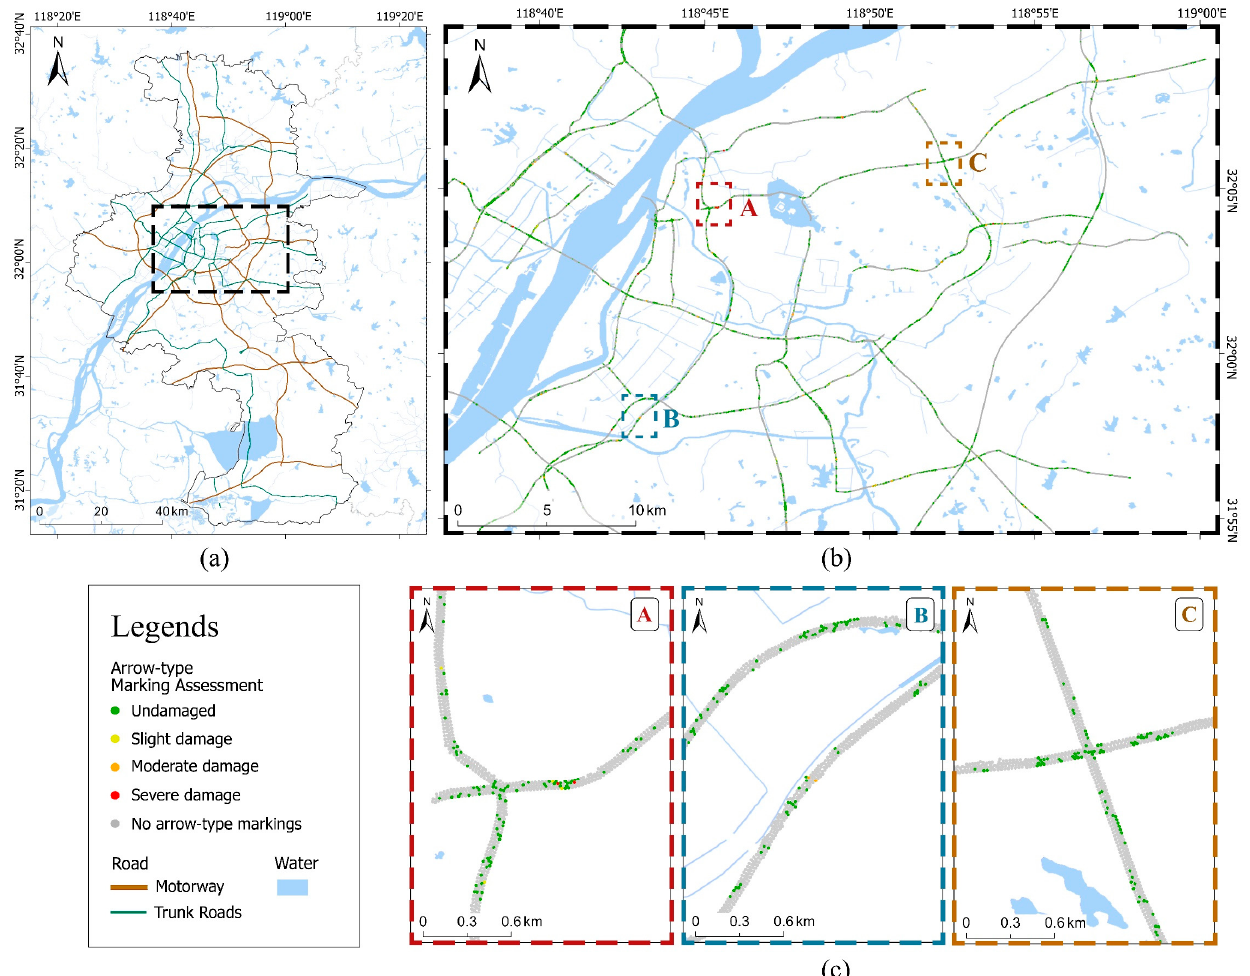
Figure 10. The assessment results for arrow-type pavement markings of each sampling point in Nanjing. ( a ) Location of detected roads in Nanjing, ( b ) an overview of the assessment results of arrow-type markings, and ( c ) a detailed display of the marked areas in panel ( b ).